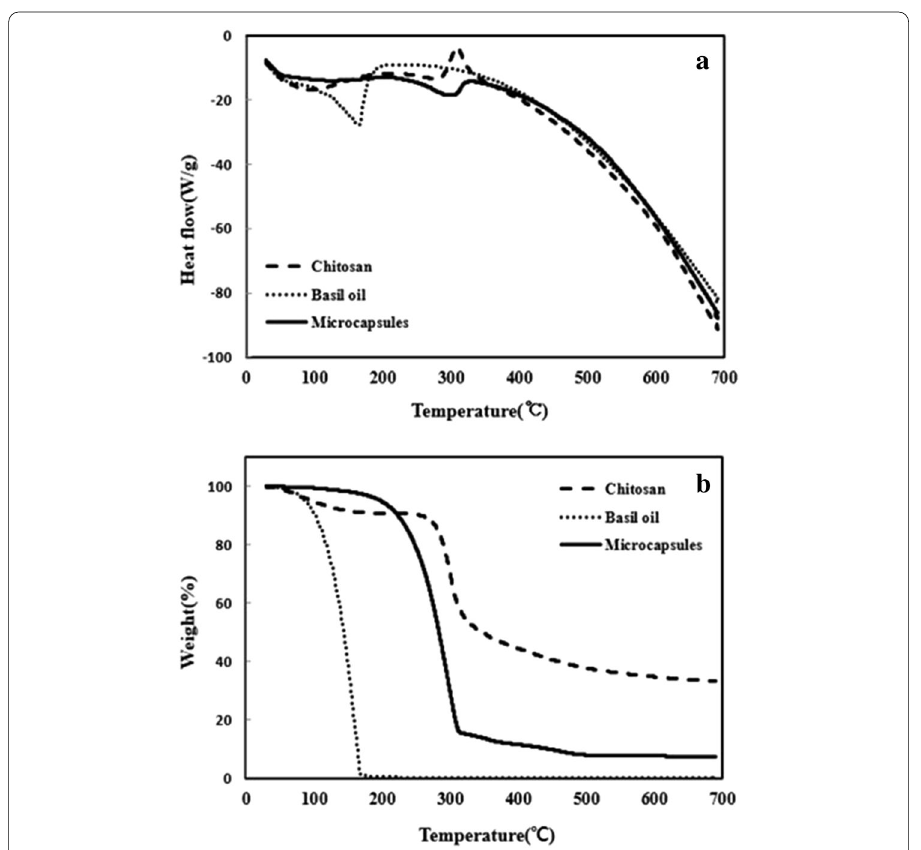
Fig. 7 a DSC and b TGA curves of microcapsules, chitosan, and basil